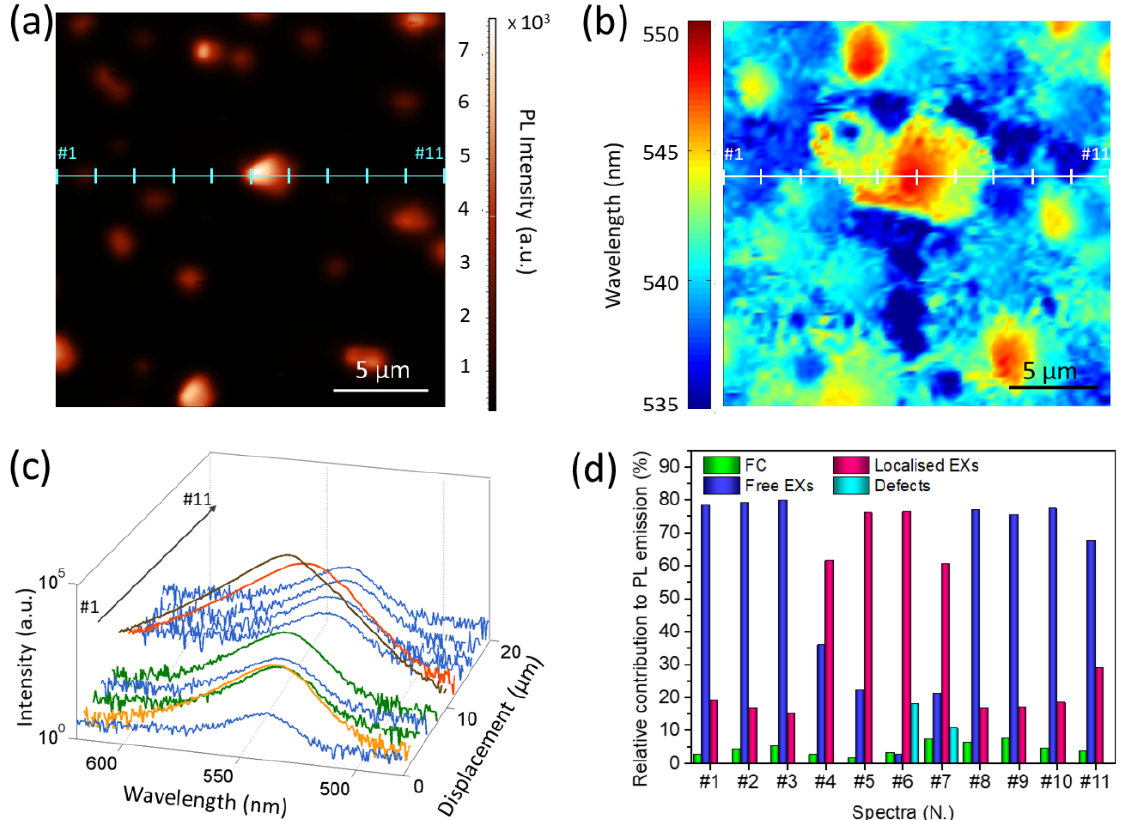
Figure 3. ( a ) Micro-PL intensity map of sample A acquired in reflection mode; ( b ) map of the wavelengths of the maximum PL emission, as derived from micro-PL map in sample A (panel a); ( c ) PL spectra, recorded in sample A along a selected direction (signed by the cyan line in panel a) acquired at different locations, with 2 µm spacing distance from each other; the same color as in panel b are used. For a better comparison, a logarithmic scale is selected to show their intensity; ( d ) relative amount of FC, free, localized EXs, and defects estimated as fractional area contribution of each emissive species for each spectrum shown in panel c. All data, including the real counts of the acquired optical signal in correspondence with the wavelength emission, are reported in Table S1.